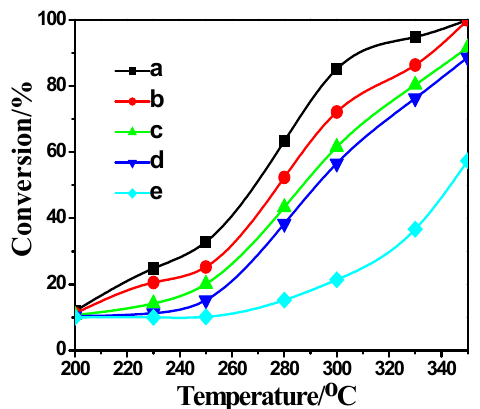
Figure 6. Activity measurement results of N 2 O direct dissociation over Ce x C 1 − x Co 2 O 4 ( x = 0.03, 0.05, 0.1, 0.2) composite spinel metal ‐ oxide catalysts. Reaction conditions: N 2 O:He = 35:65, GHSV = 30,000 h − 1 ; ( a ) Ce 0.05 Co 0.95 Co 2 O 4 ; ( b ) Ce 0.03 Co 0.97 Co 2 O 4 ; ( c ) Ce 0.1 Co 0.9 Co 2 O 4 ; ( d ) Ce 0.2 Co 0.8 Co 2 O 4 ; ( e ) Co 3 O 4 .